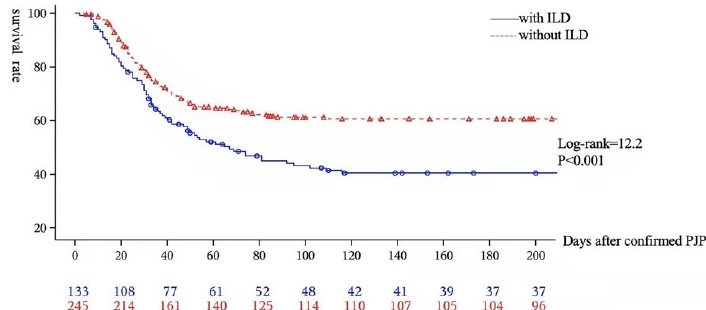
Figure 3. Kaplan–Meier survival analysis for all enrolled PJP patients. The all-cause mortality rate for the PJP in interstitial lung disease (ILD-PJP) group is higher than that of the non-ILD-PJP group (log-rank = 12.2, p < 0.001).